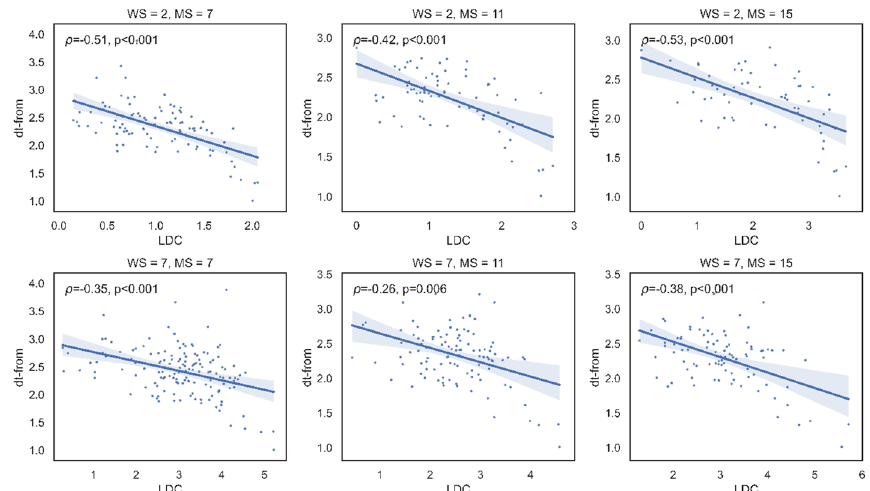
Fig. 8 Six examples of the correlation between LDC and dt-from for WS: 2,7 and MS: 7,11,15. The x-axis denotes LDC and the y-axis denotes dt-from